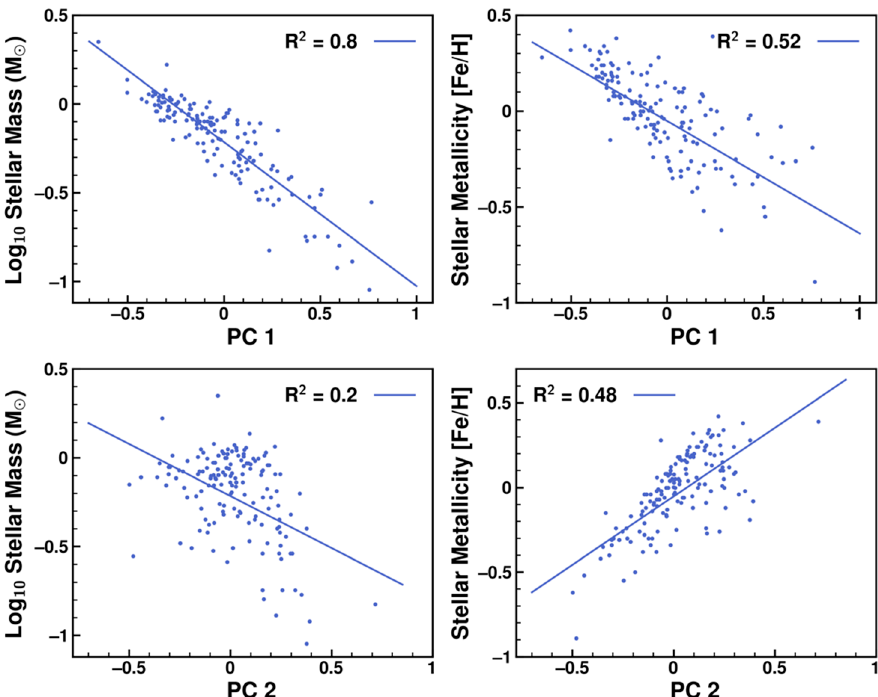
Figure 5. Scatter plots of stellar mass and stellar metallicity versus principal components. Unit of stellar mass is solar-mass. Unit of stellar metallicity is [Fe/H]. The linear regression gives the R 2 value between each principal component and each stellar parameter.